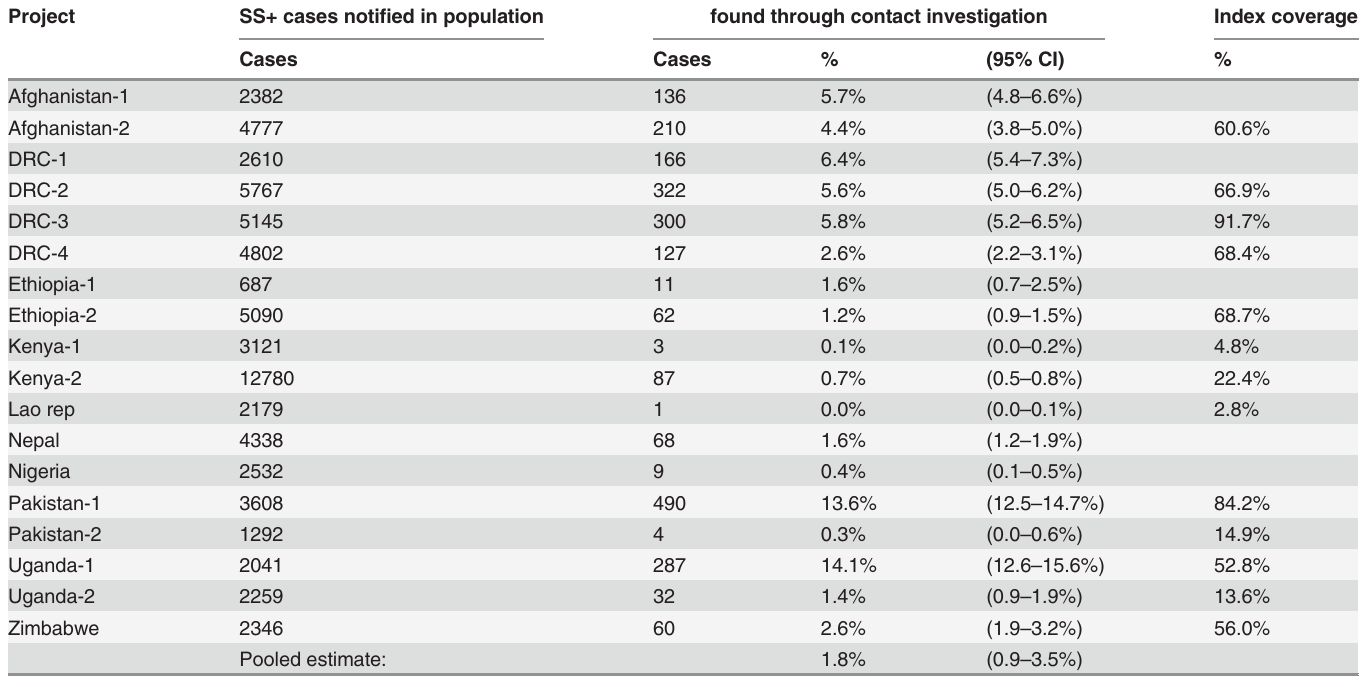
Table 5. Yield of active case fi nding and proportion of noti fi ed SS+ cases found through contact investigation (n = 18).